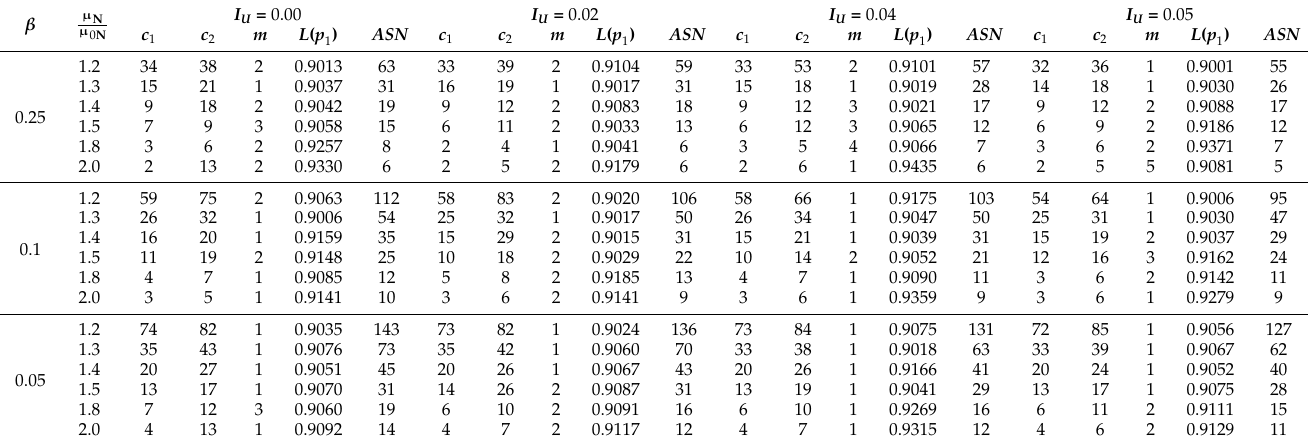
Table 2. The MDS design values for α = 0.10, ν = 2.0, and a = 1.0.